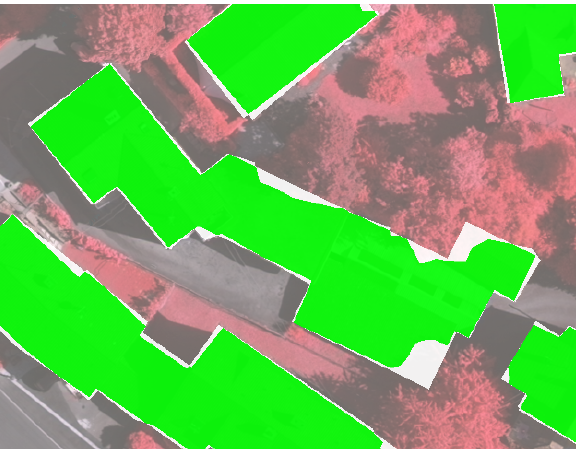
Figure 6. Ground truth (green) and acquisition (white). Both are uncertain especially because of the possible interpretations of